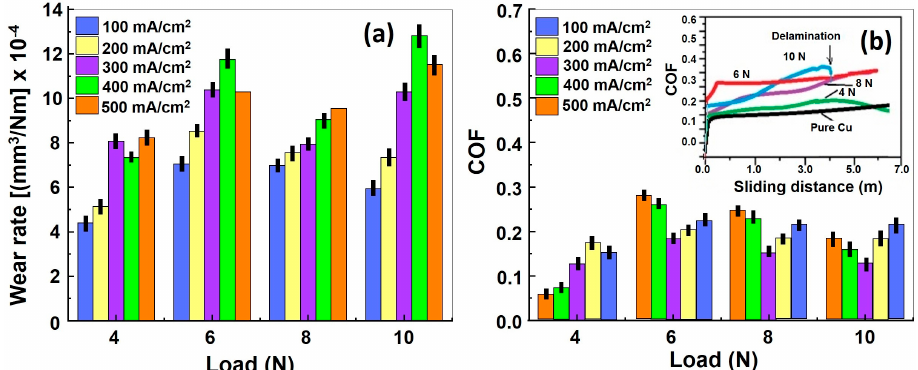
Figure 8. Variation of ( a ) mean wear factor, and ( b ) mean coefficient of friction (COF) at different loads as a function of current density and normal loads. The inset shows the COF vs. sliding distance.